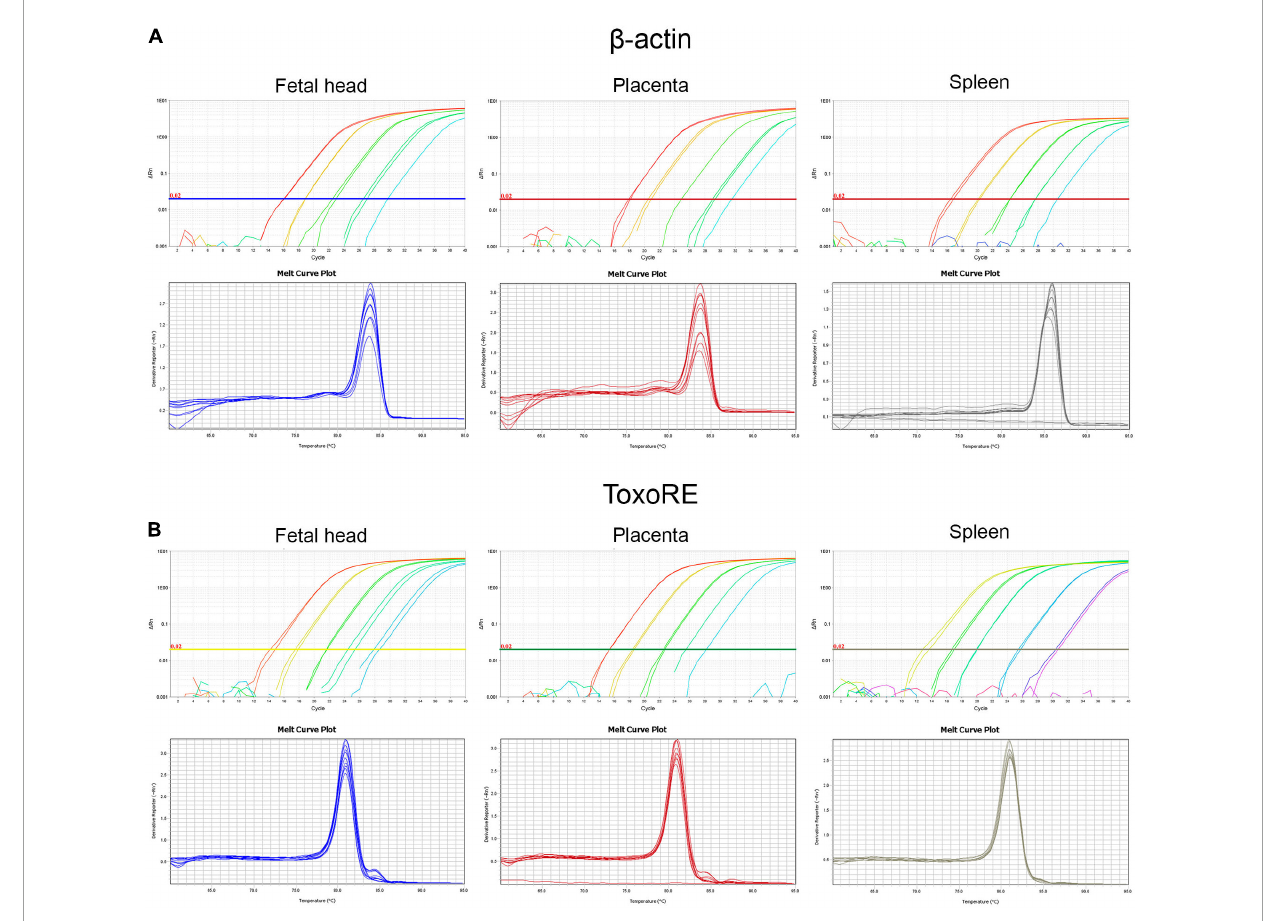
FIGURE6 Standardization of qPCR assays to assess the burden of T. gondii in fetal (E13.5–14.5) and maternal tissues. Upper panels show representative amplification plot with fluorescent signal magnitude for β -actin (A) and ToxoRE (B) targets. Lower panels show melting curves indicating the specificity of the reaction, seen through a single peak in each curve for the β -actin (A) and ToxoRE (B) targets.